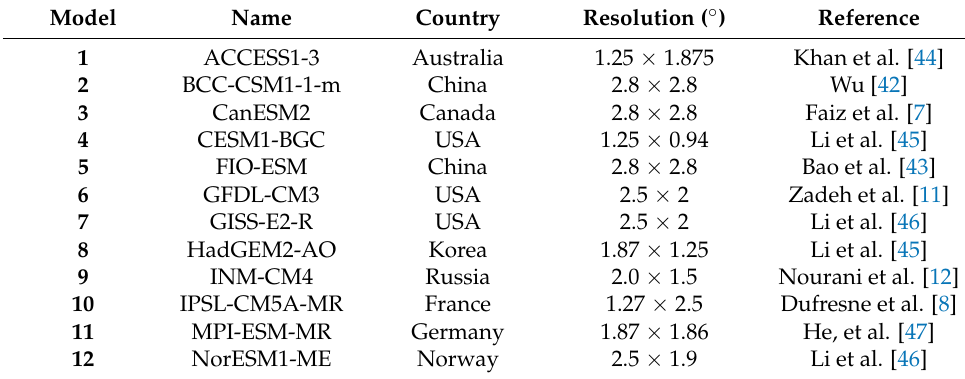
Table 2. CMIP5 model used in this